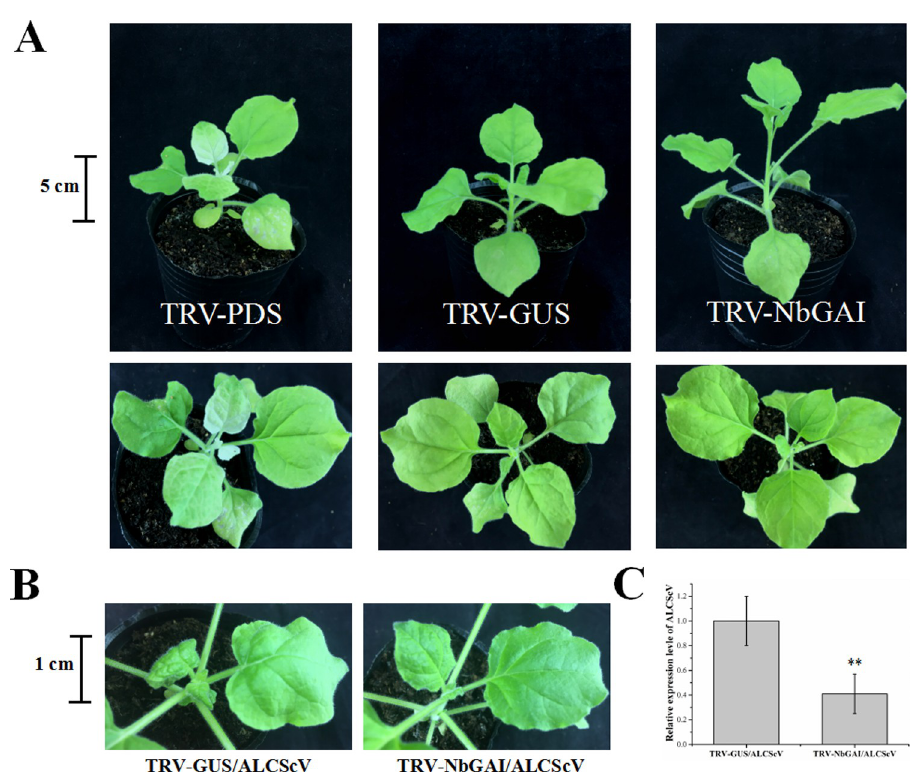
Fig 8. Silencing of NbGAI expression in N . benthamiana plants through VIGS inhibits ALCScV infection. (A) Symptoms of the N . benthamiana plants inoculated with TRV-PDS, TRV-GUS or TRV-NbGAI at 7 dpi. (B) The TRV-GUS- and ALCScV-inoculated N . benthamiana plants had stronger symptoms of leaf curling and plant dwarfing than the TRV-NbGAI- and ALCScV-inoculated N . benthamiana plants at 14 dpi. The results were reproduced in three independent experiments using 10 plants per treatment. (C) The qPCR analysis shows that the accumulation of ALCScV DNA in the TRV-NbGAI- and ALCScV-inoculated plants was significantly reduced compared to the TRV-GUS- and ALCScV-inoculated plants. �� indicates a significant difference between the two treatments at the P < 0.01 level. These experiments were performed with three independent biological replicates with similar results.